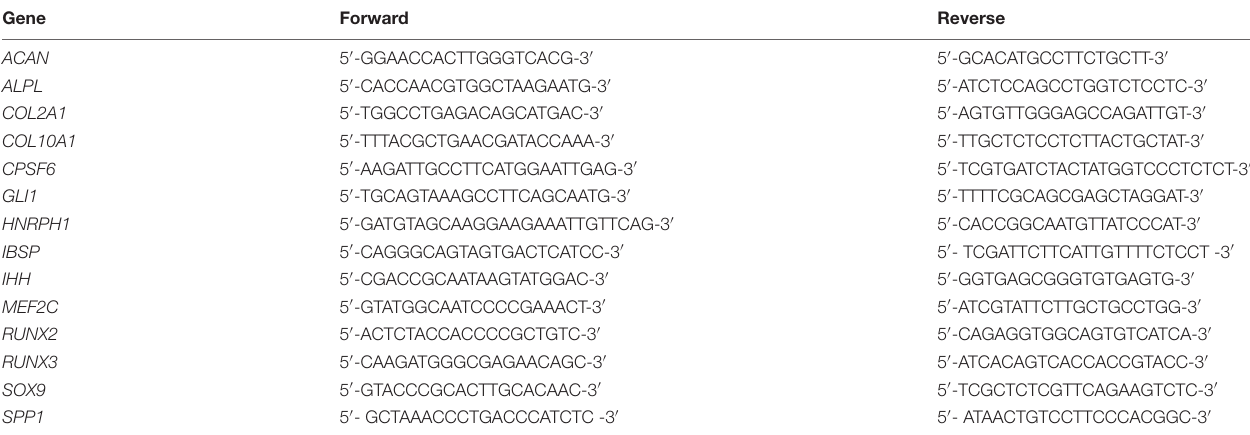
TABLE 1 | Primer pairs for qRT-PCR analysis in alphabetical order. Gene